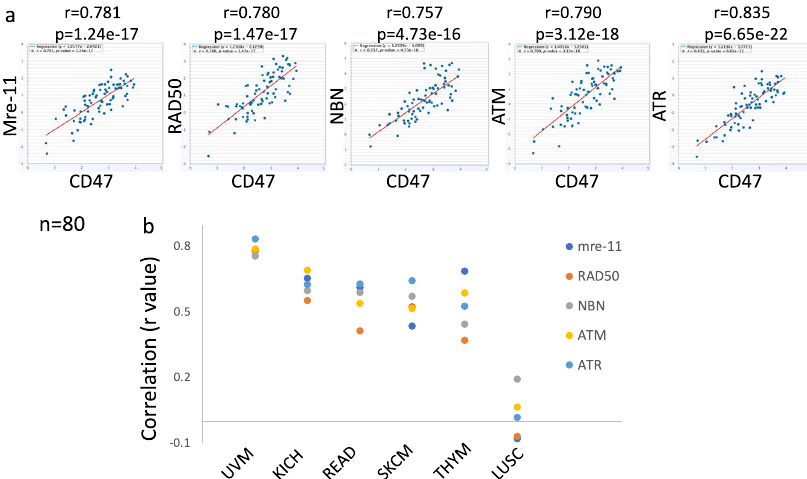
Fig. 6 CD47 expression correlates with DDR genes in human tumors. a Correlation between CD47 and either mre-11, ATM, ATR or RAD50 expression scores in tumor tissue of uveal melanoma (UVM) patients, is illustrated in scatter plots using StarBase. Spearman ’ s rank-correlation coef fi cient r and p value are shown. b Summary of rank-correlation coef fi cients between indicated DDR gene and CD47 expression scores. Lung Squamous Cell Carcinoma (LUSC) represents tumors where CD47 and DDR genes expression do not correlate. UVM uveal melanoma, KICH kidney chromophobe, READ rectum adenocarcinoma, SKCM skin cutaneous melanoma, THYM thymoma, COAD colon